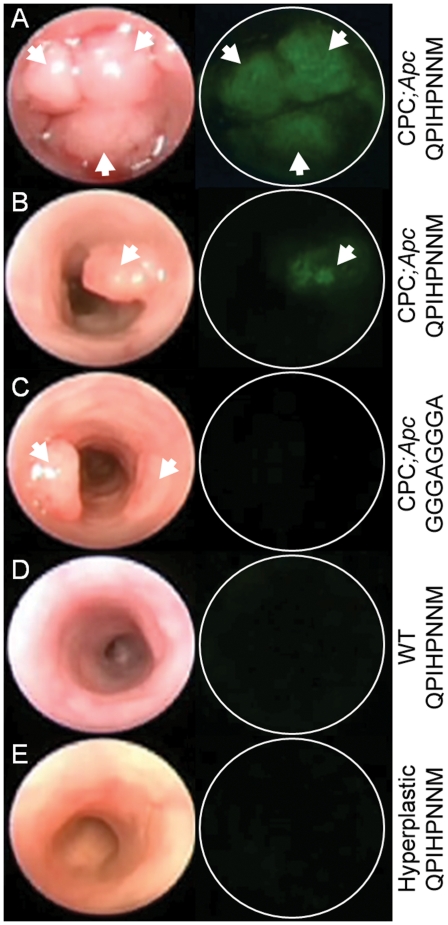
Images from wide-field endoscopy videos after application of
fluorescence-labeled peptides.The left and right columns represent frames from white light and
fluorescence, respectively. The fluorescent labeled target peptide
FITC-Ahx-QPIHPNNM
showed positive binding to (A) multiple adenomas and (B) single adenoma
in a CPC;Apc mouse. (C) The control peptide
FITC-Ahx-GGGAGGGA
showed minimal binding. The target peptide also showed minimal binding
to (D) the lumen of a CPC;Apc bred mouse negative for
Cre recombinase (control litter mate) and (E) the hyperplastic
epithelium in a mutant Kras mouse model. White arrows
identify adenomas.